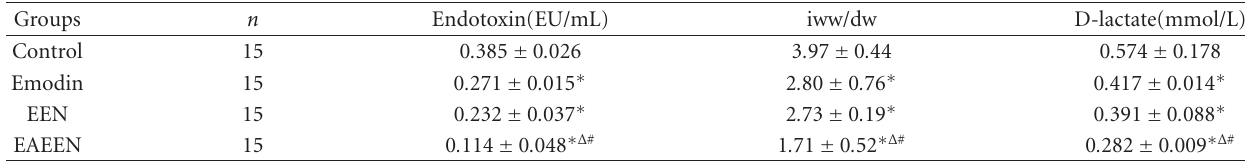
Table 2: Levels of endotoxin, iww/dw, and D-lactate in 4 groups (EEN: early enteral nutrition. EAEEN: emodin-assisted early enteral nutri- tion. iww/dw: wet-dry weight ratio of ileum).